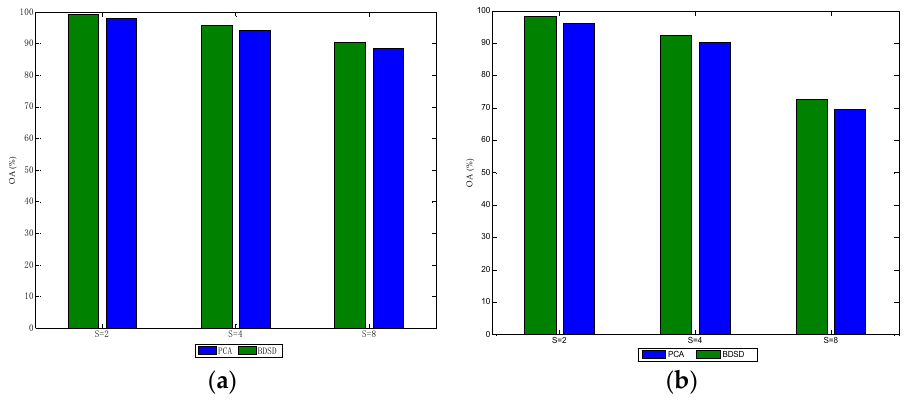
Figure 17. ( a ) OA (%) of the SRMSAM-PAN results in relation to the band-dependent spatial detail (BDSD) and PCA in Experiment 2. ( b ) OA (%) of the SRMSAM-PAN result in relation to BDSD and PCA in Experiment 3.